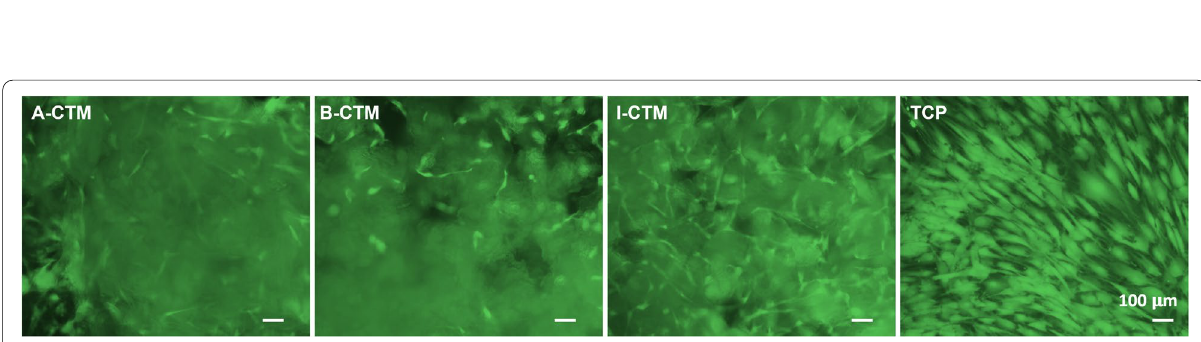
Fig. 3 Viable tenocytes on different connective tissue matrices. Cells on different connective tissue matrices on day 7 were stained with Calcein AM. The images were captured using epi-fluorescent microscope. Representative images of each group are shown. Scale bar Abbreviations: A-CTM, AmnioFill ® connective tissue matrix; B-CTM, BioRenew ™ connective tissue matrix; I-CTM, Interfyl ® connective tissue matrix; TCP, tissue culture